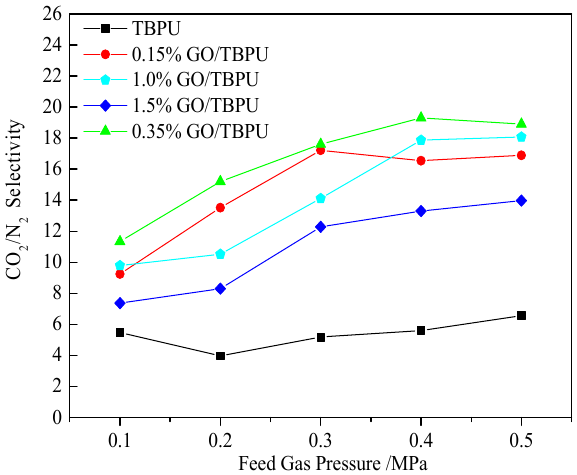
Figure 9. CO 2 /N 2 selectivity of nanocomposite membranes under different pressures.